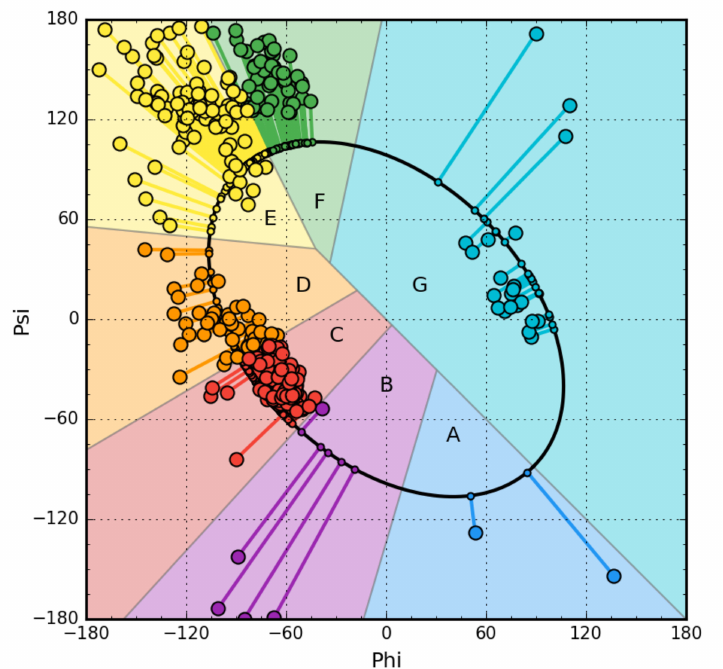
Figure 1. Example of Phi and Psi angle map for chain A from NAD-dependent formate dehydrogenase from higher-plant Arabidopsis thaliana in a complex with NAD and azide (PDB ID: 3N7U) [40]. This protein has been selected due to its large size (351 aa per chain), allowing su ffi cient representation of secondary structure elements in all structural code zones. The lines represent the transformation of Phi and Psi into Phi e and Psi e